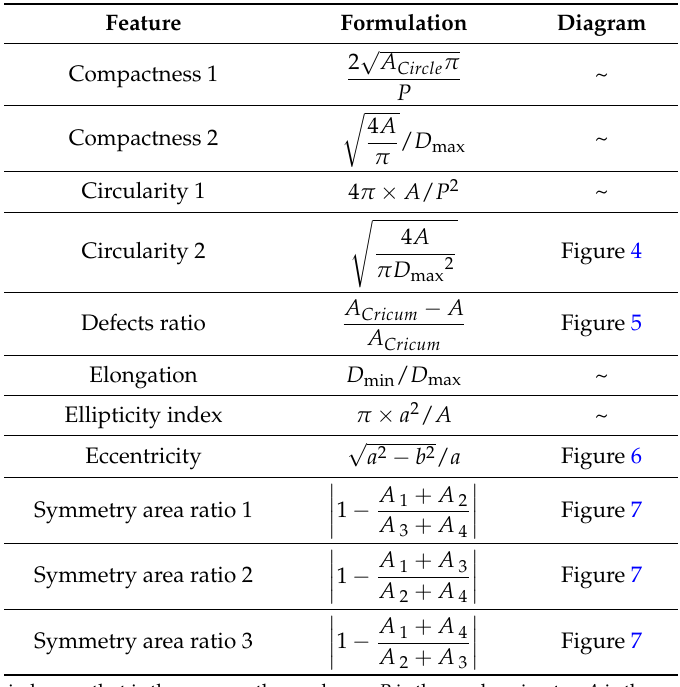
Table 1. Mathematical formulations of shape features.